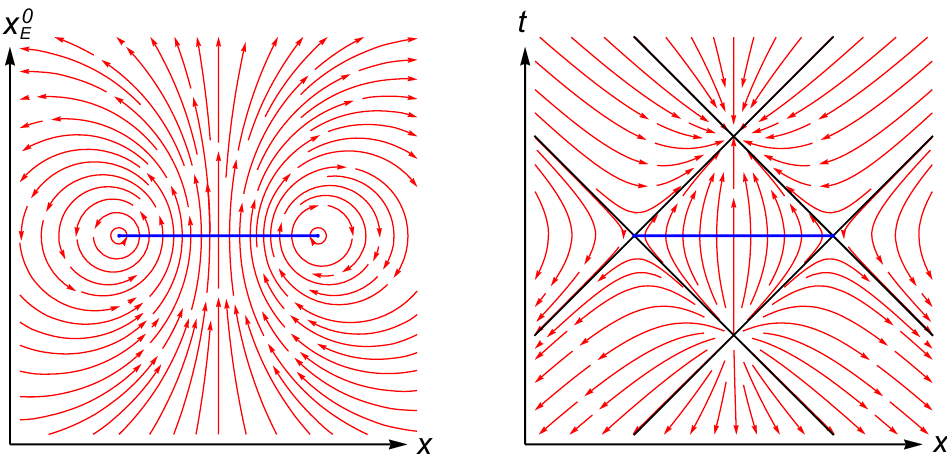
Figure 2 . The (cid:13)ow generated by the modular Hamiltonian of the region A (in blue). We start by working in Euclidean time x 0 , depicting the vector (cid:12)eld @ (cid:28) on the left. The calculation then E introduces an imaginary shift in (cid:28) , which results in a displacement of the operator insertion into real time t . The picture of the real time vector (cid:12)eld @ s = 1 (cid:16) A is shown on the right with the 2 (cid:25) causal structure indicated in gray. The two plotted planes can be thought of as orthogonal to each other and sewn together along the region A